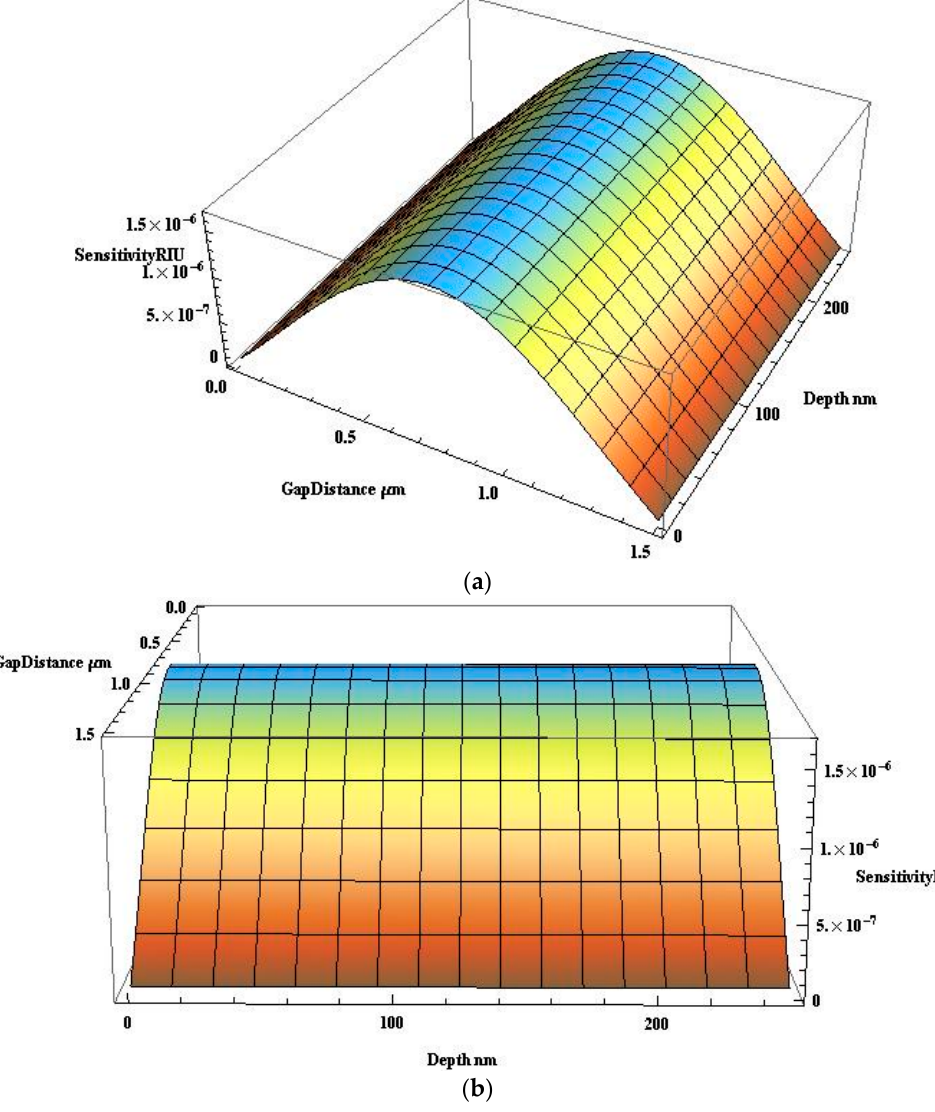
Figure 13. ( a ) Sensitivity in RIU (View 1); and ( b ) sensitivity in RIU (View 2).